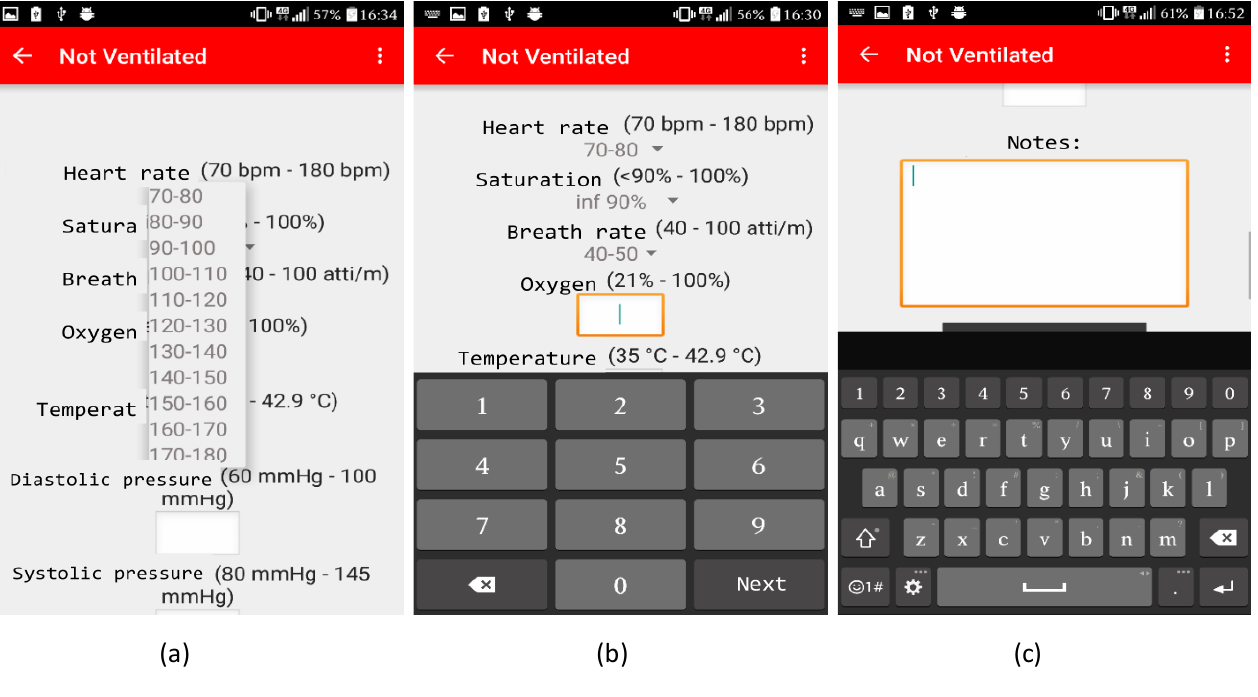
Figure 3. Snapshots of 3 activities in the operator